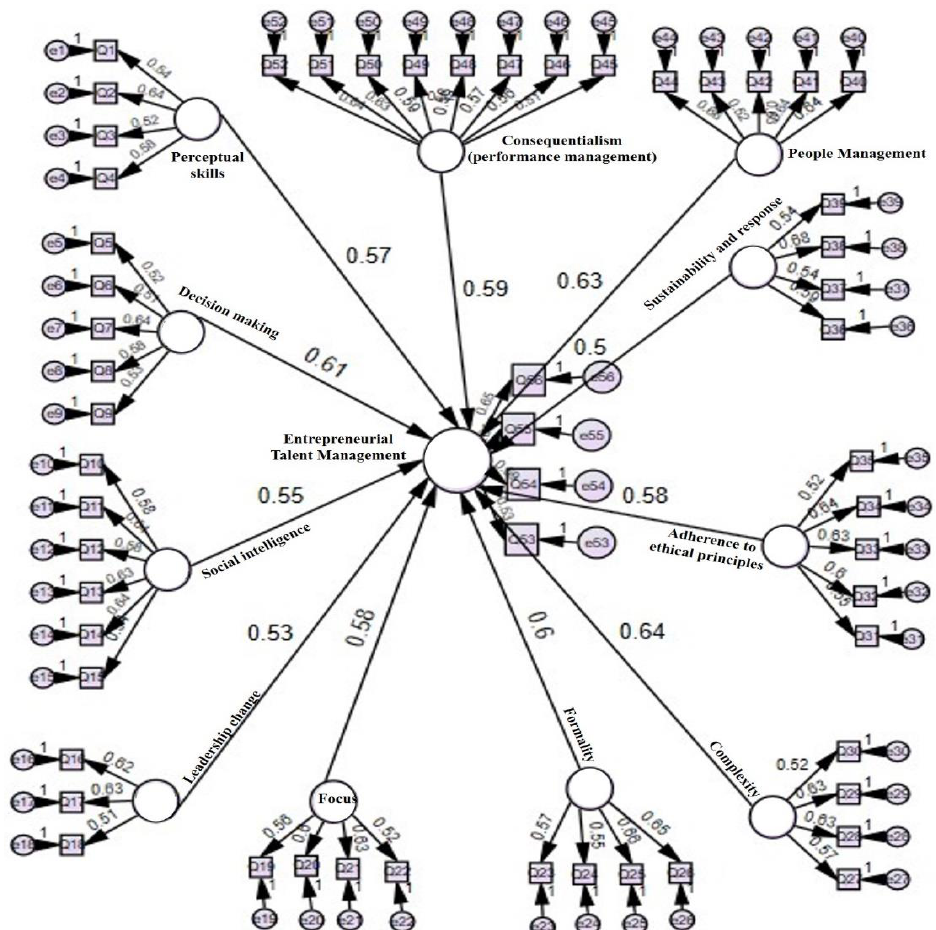
Fig. 2: Structural equation model of the research structure, in standard Fig . 2: Structural equation model of the research structure, in standard mode